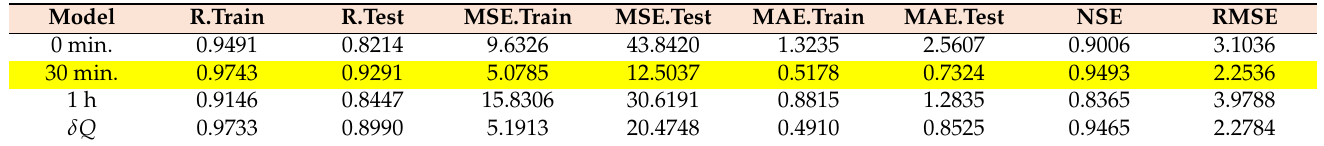
Table 4. Performance of LSTM with firefly algorithm models for streamflow.